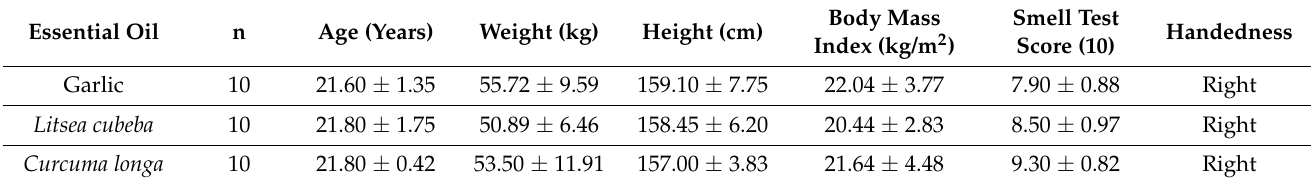
Table 3. Baseline characteristics for brainwave studies. Data are shown as the mean ± standard deviation. Essential